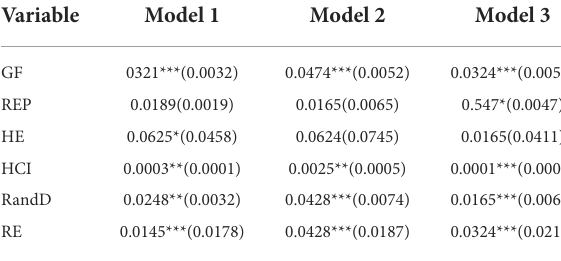
TABLE 10 Threshold regression